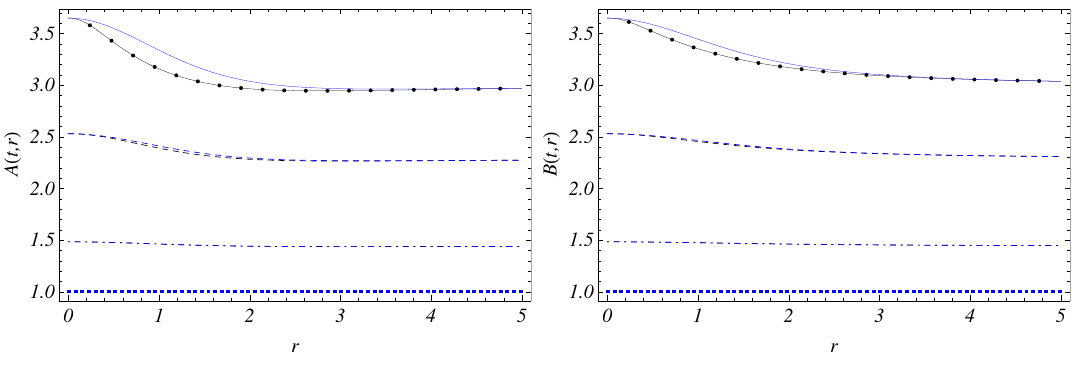
Figure 7. Evolution of the scale factors A ( r, t ) and B ( r, t ) profile for η = 0 . 1 (black lines) and η = 0 . 6 (blue lines) from the time t up to the present time t . A mesh of dots is 0 p superimposed to the curve corresponding to η = 0 . 1 , t = t to distinguish it from the p / 3 curve obtained for η = 0 . 6 , t = t . The profiles shown correspond to t (dotted line), t p 0 p / 3 (dashed line), t (dot-dashed line), 2 t (solid line). Higher curves correspond to more p p recent times. The (rescaled) comoving region of accelerated expansion is slightly smaller in the case of η < 0 . 3 since the monopole core does not expand in this case (from [79]).